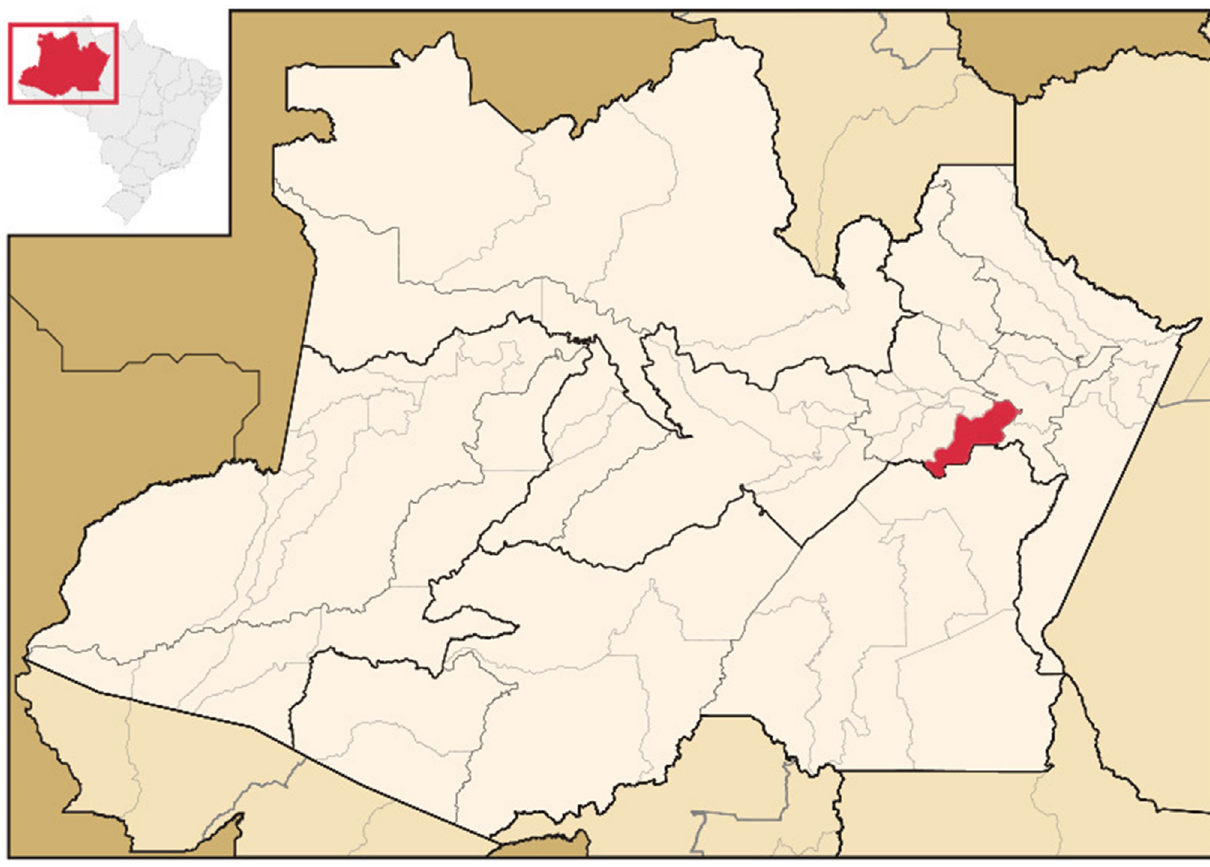
Figure 1. Geographical location of the municipality of Autazes in Manaus, Amazonas. SIASI/SESAI/MS